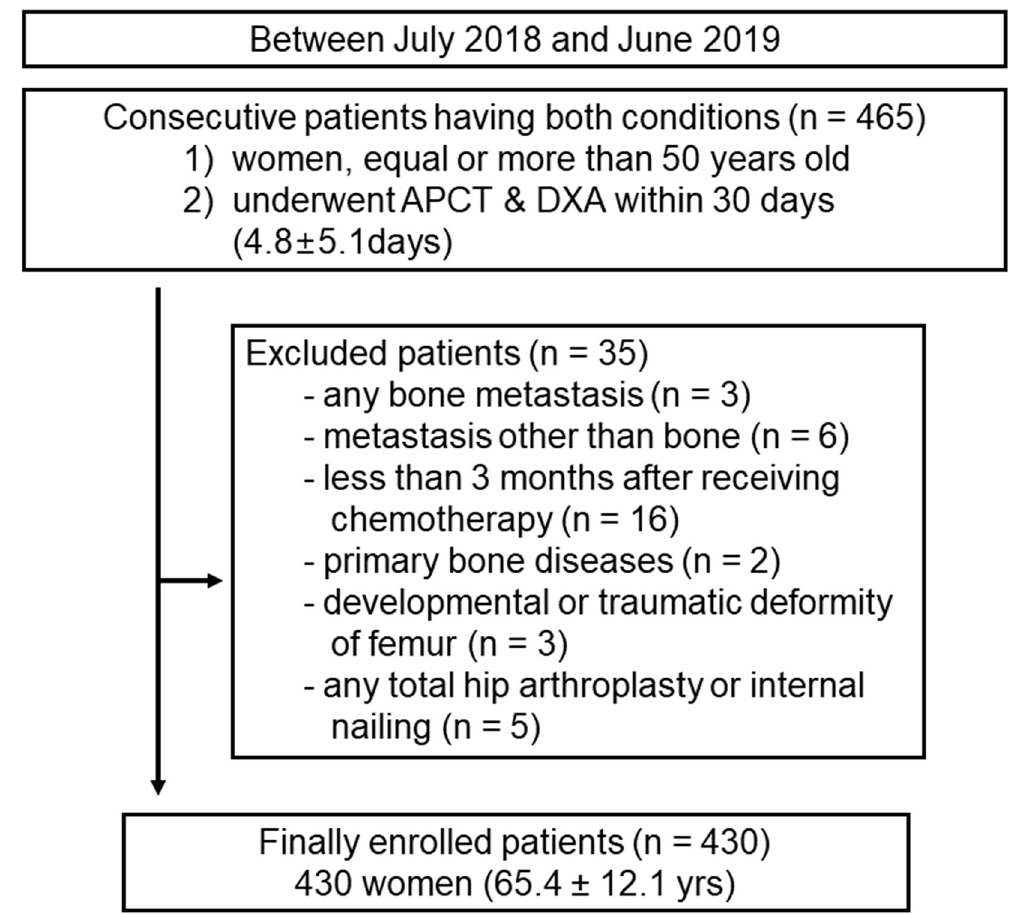
Fig 1. Flowchart of patient